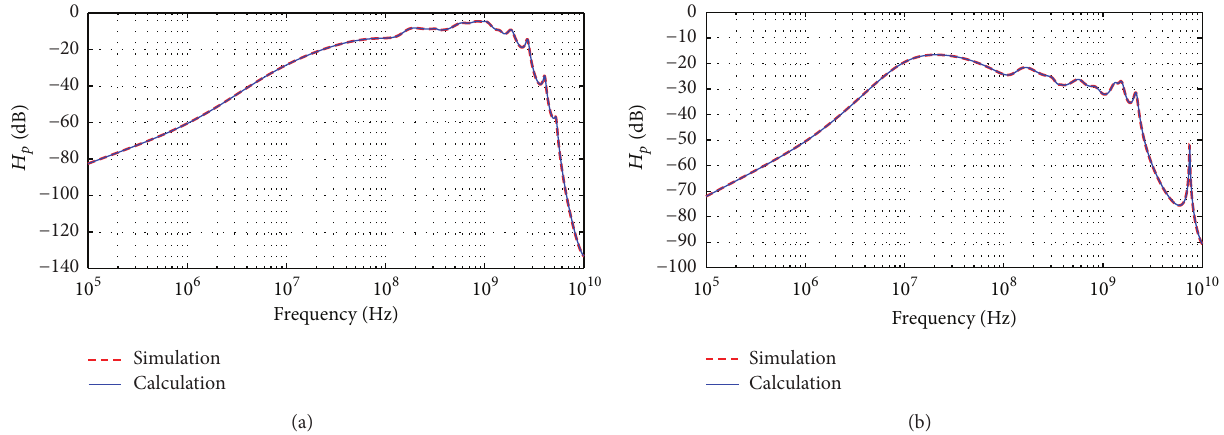
Figure 16: Power transfer efficiency ( 𝐻 𝑝 ) comparison. (a) DPI method. (b) BCI method.